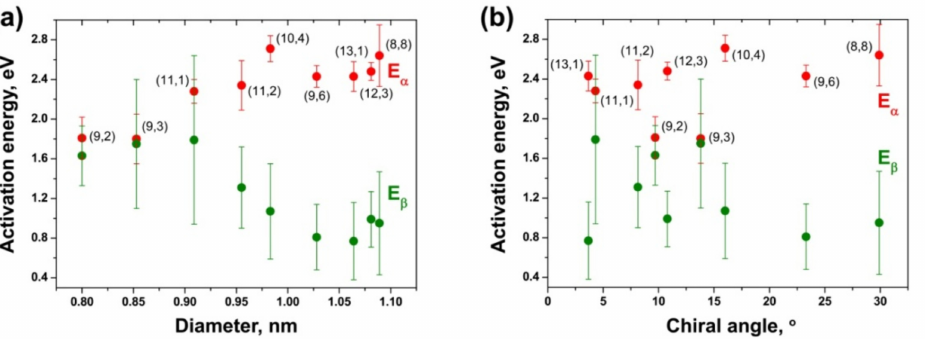
Figure 16. The activation energies E α and E β of the growth of the inner tubes with the chiralities of (8,8), (12,3), (13,1), (9,6), (10,4), (11,2), (11,1), (9,3) and (9,2) upon in situ annealing of the cobaltocene- filled SWCNTs plotted versus the tube diameter ( a ) and chiral angle ( b ). The chiralities of inner tubes are denoted near the corresponding